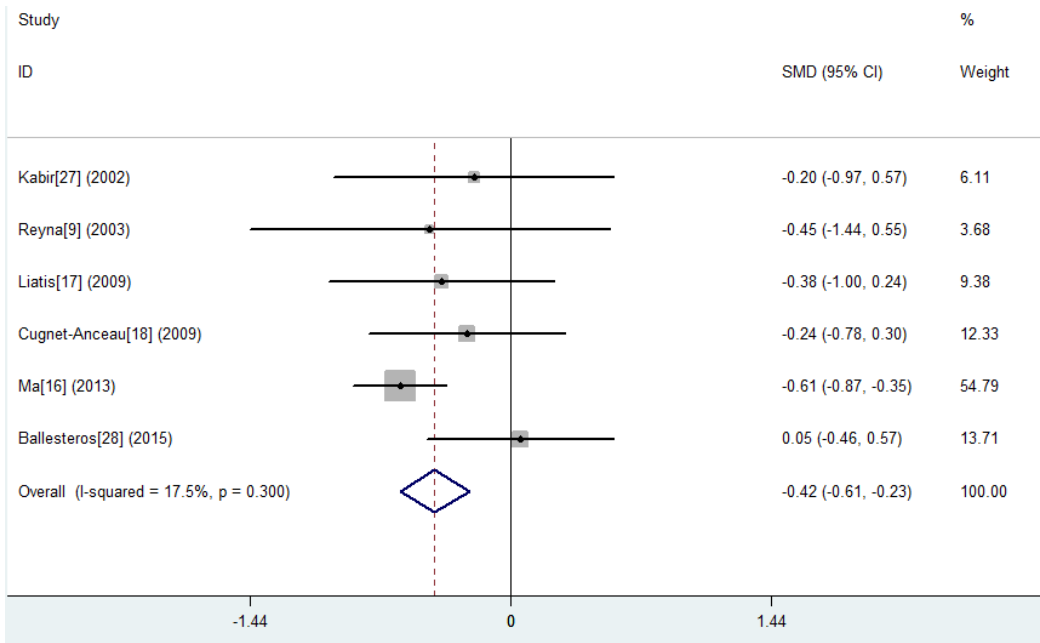
Figure 2. Results of the meta-analysis carried out to investigate the effect of oats intake on glycosylated hemoglobin A1c (HbA1c). The changes from baseline (Mean ± SD) between the two groups were compared. MD, mean difference; CI, confidence interval.